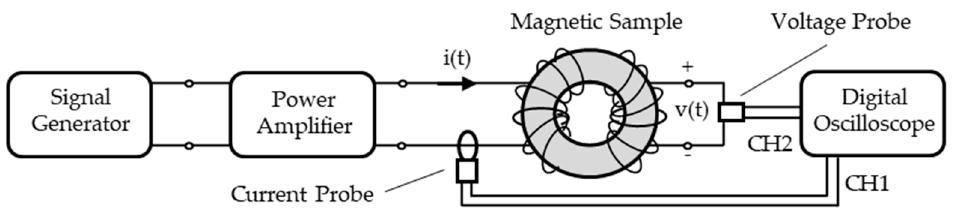
Figure 5. Experimental set-up for the magnetic property measurement of the samples in FeSi3 and FeSi6.5.